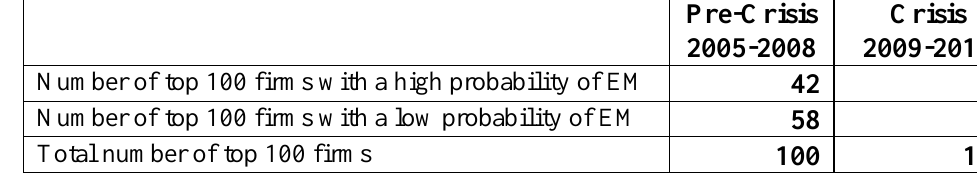
Table 5: Manipulation Scores on Top 100 by Sales